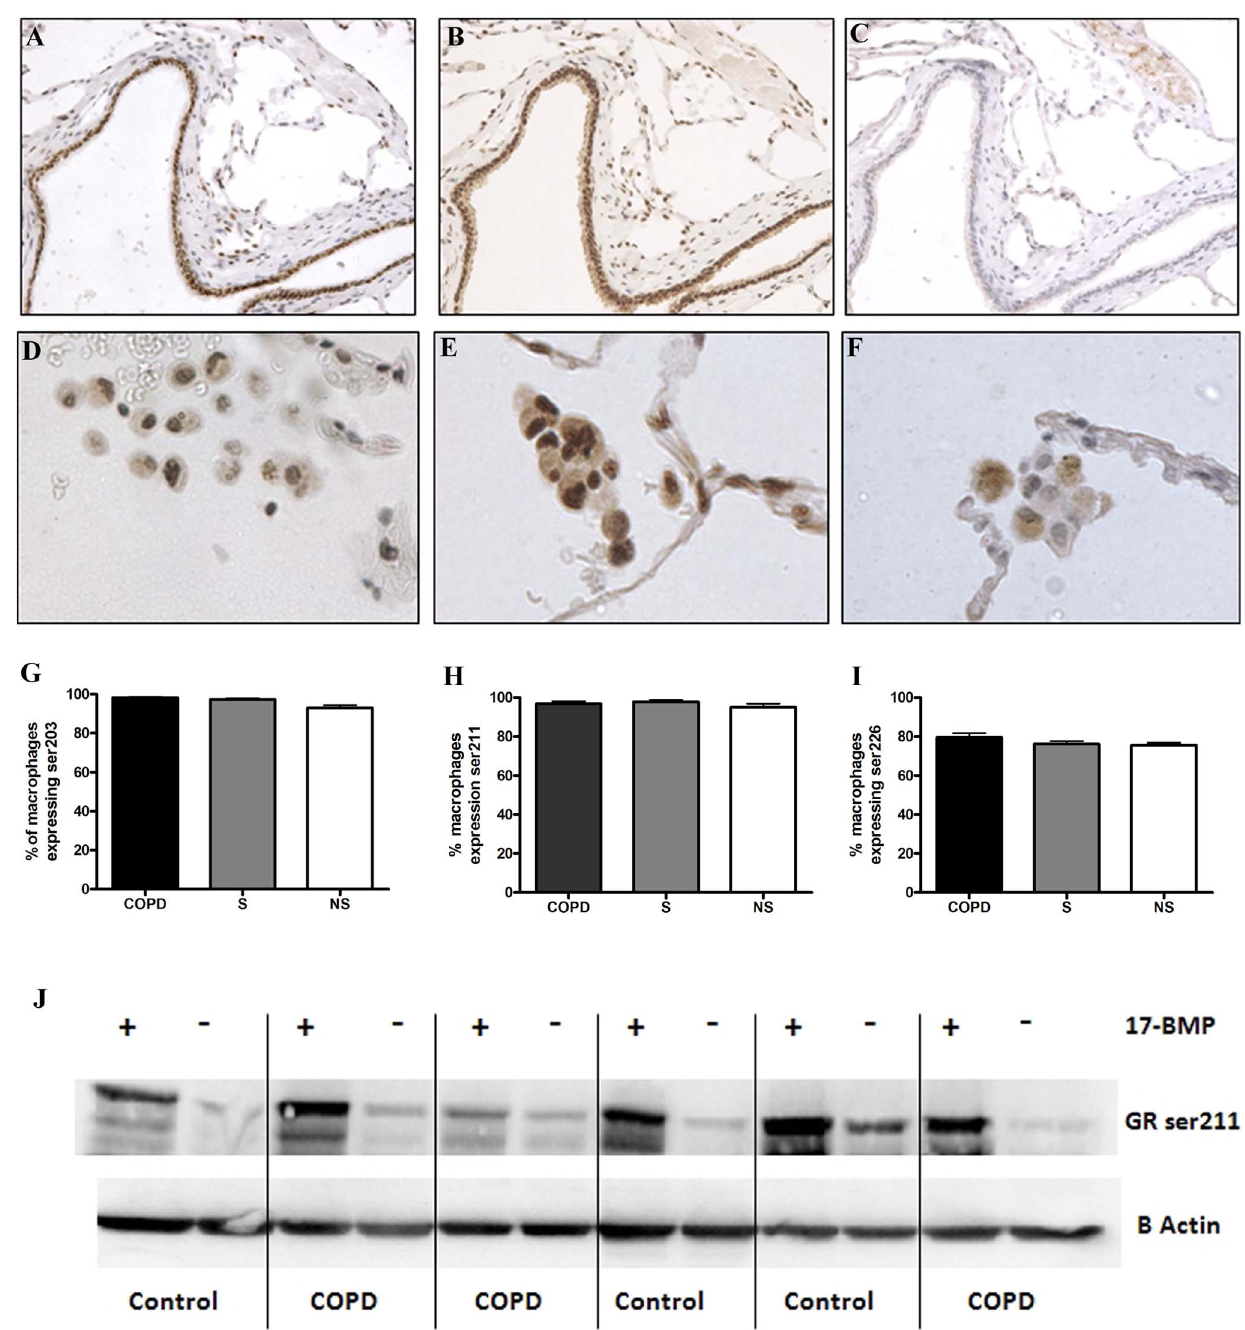
Figure 6. Glucocorticoid receptor phosphorylation. GR phosphorylation status was examined in situ via immunohistochemistry in COPD (n=16), S (n=9) and NS (n=11). (A–C) GR phosphorylation at ser203, ser211 and ser226 on serial sections through the same small airway. (D–I) GR was phosphorylated at ser203, ser211 and ser226 within alveolar macrophages from all groups. Data are presented as mean (SEM). (J) Examination of GR phosphorylation was examined ex vivo via western blotting. Lung macrophages were treated for 1 h with 1 m M 17-BMP and cell lysates analysed for ser211 phosphorylation. Blot representative of samples from COPD (n=6) and smoking controls (n=6). Different subjects were used in the immunohistochemical analysis and the ex vivo analysis.